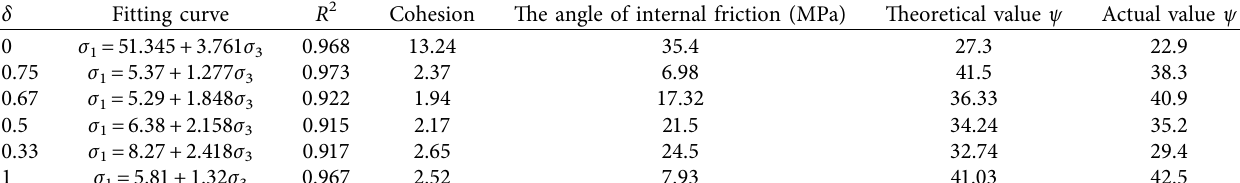
Table 3: M-C criterion fitting parameters and R 2 .